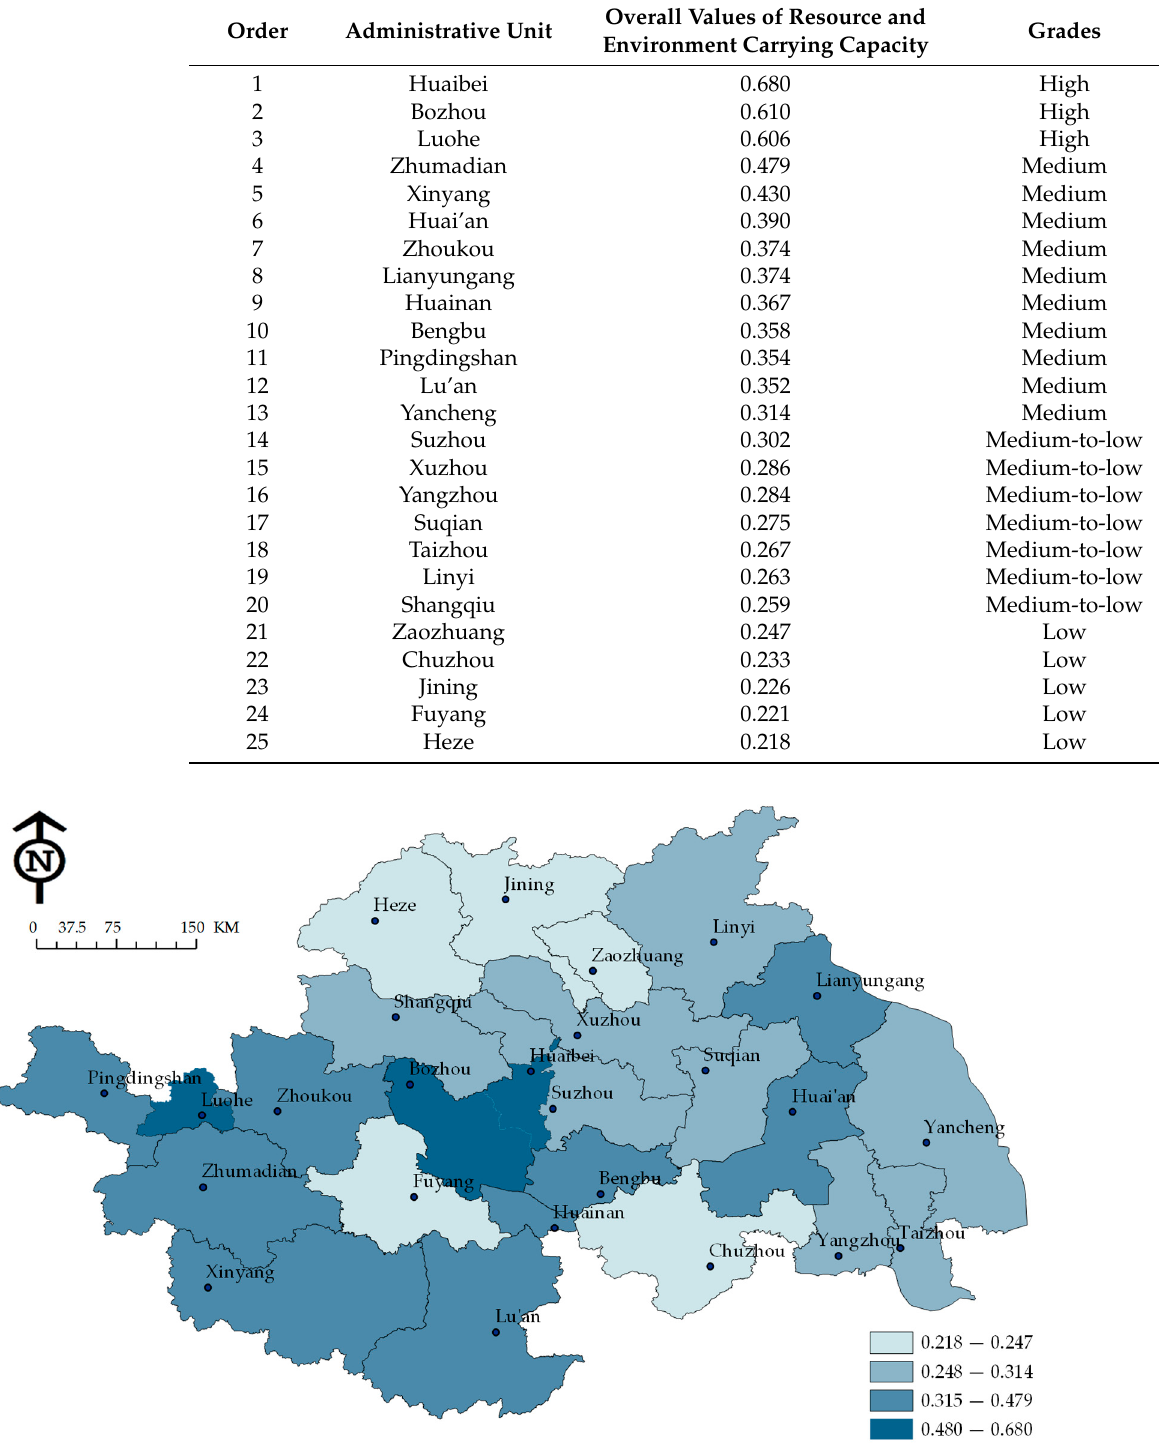
Table 5. Calculated values of resource and environment carrying capacity and the grading results.